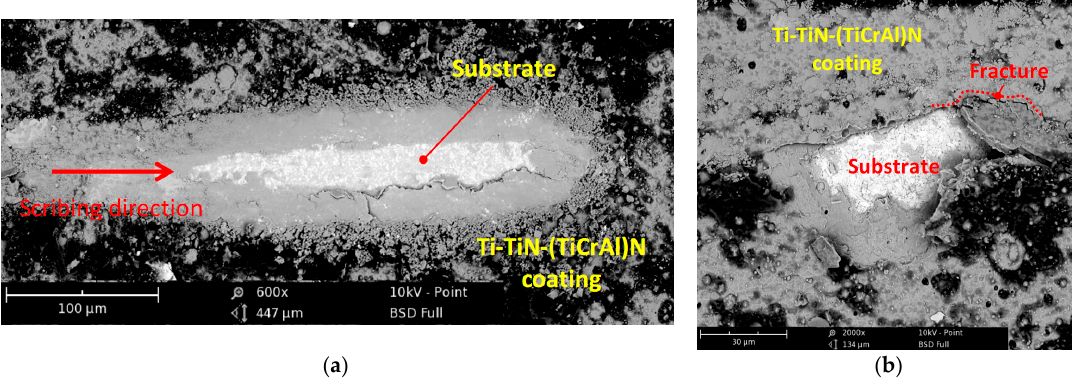
Figure 2. Fracture pattern for multilayered nano-structured coating Ti-TiN-(TiCrAl)N (thickness of about 3 µm) in scratch testing: ( a ) General view of scribing groove in area of L c1 – L c2 ; (b) Area of coating spallation from substrate.